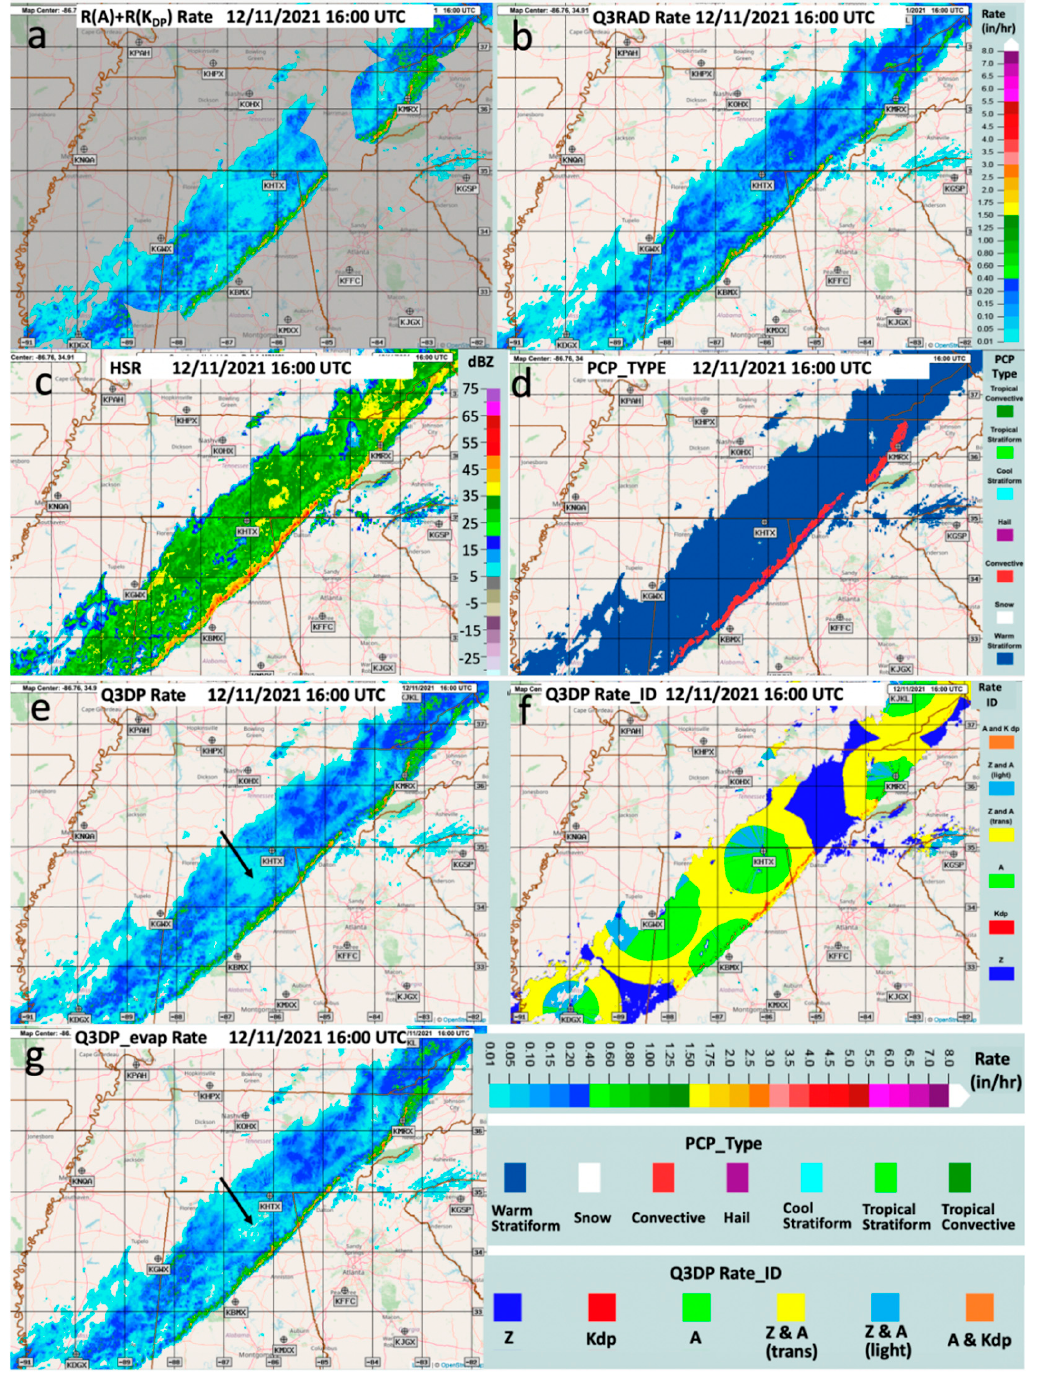
Figure 21. ( a ) R ( A ) + R ( K DP ) rate mosaic, ( b ) multiple R ( Z ) rate, ( c ) hybrid scan reflectivity mosaic, ( d ) precipitation type, ( e ) the R ( A ) + R ( K DP ) + R ( Z ) DP synthetic QPE, ( f ) the DP synthetic QPE categories, and ( g ) the DP synthetic QPE with evaporation correction, all valid at 1600 UTC 11 December 2021.